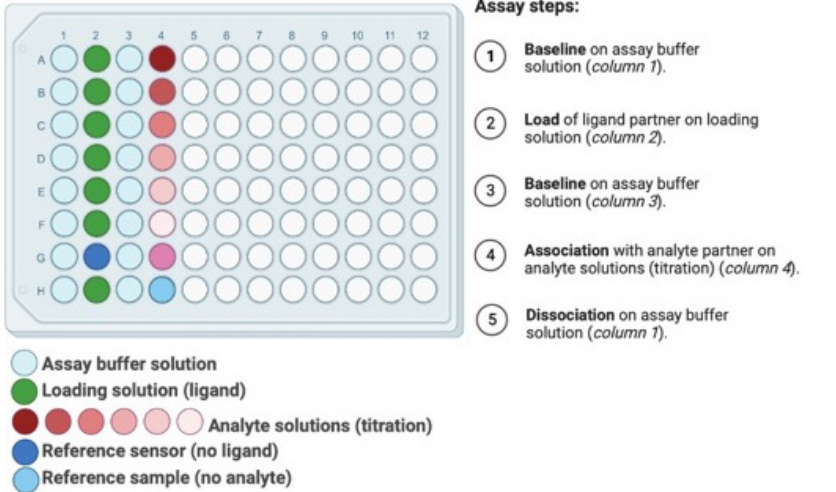
Figure 5. Plate layout for a typical BLI binding kinetics experimental plan in a 96 microwell format.